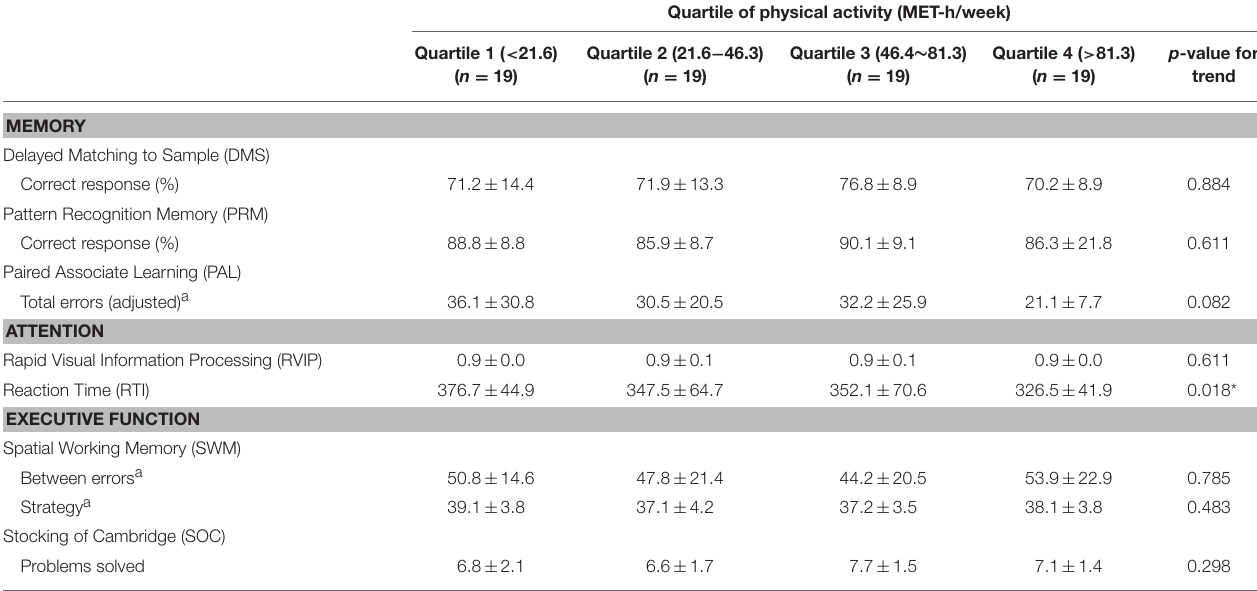
TABLE 2 | Neuropsychological tests according to physical activity quartile.